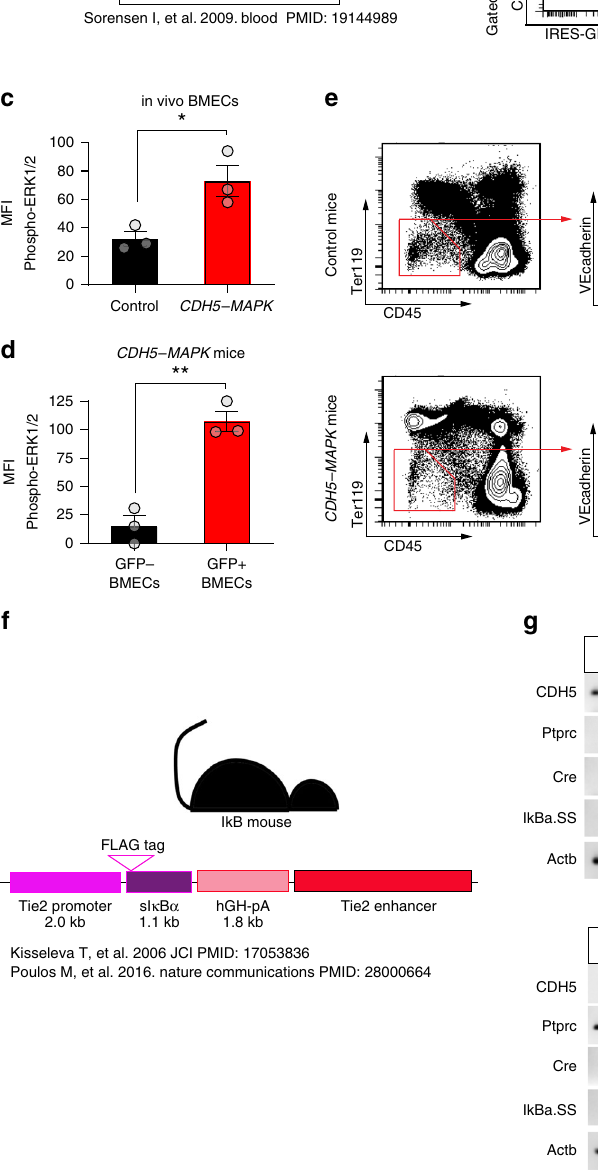
However, BM stromal cells demonstrated a loss of cycling and increased apoptosis in CDH5-MAPK mice (Fig. 7g, h). Contrarily, the quiescent nature of BMECs observed under homeostasis was disrupted in CDH5-MAPK mice likely due to the direct effect of MAPK-driven cell-cycle entry (Fig. 7g). The alterations